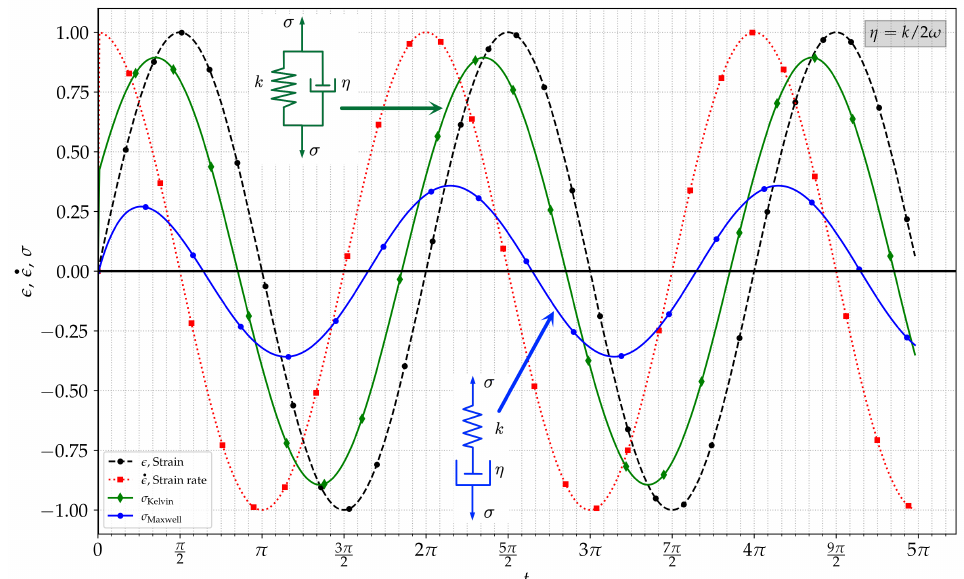
Figure 4. Strain, strain rate, and stress evolution in time for ideal Maxwell and Kelvin models forced with a synthetic strain (cid:101) = (cid:101) 0 sin ( ω t ) . Curves for (cid:101) = 1.0, ω = 1.0, k = 0.8, η = 0.5 k / ω .